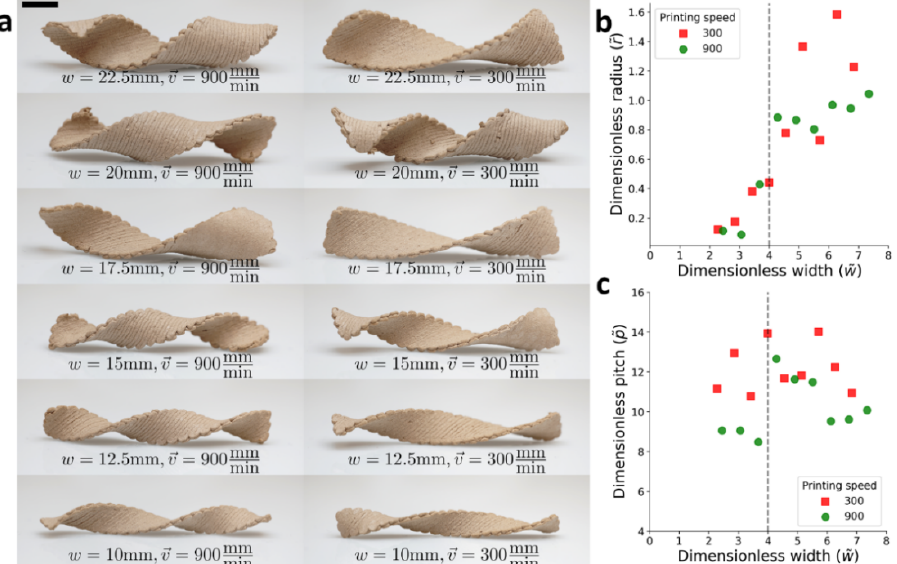
Figure 5. 45° oriented bilayers. ( a ) Dried, 3D-warped helical objects at different velocities and width, scale bar indicates 10 mm. ( b ) Dimensionless radius versus dimensionless width. ( c ) Dimensionless pitch with versus dimensionless width. The vertical dotted line represents the threshold of the shape transition.